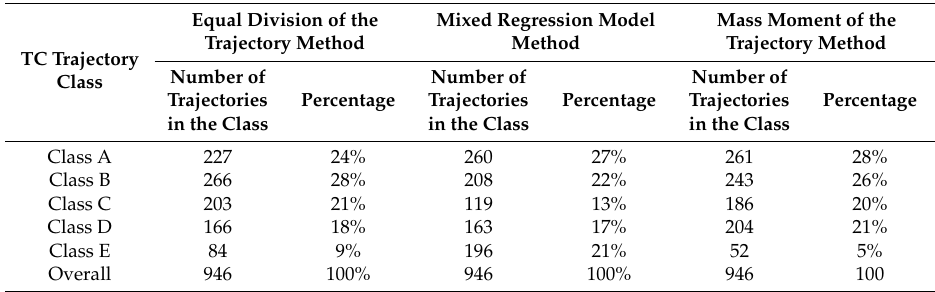
Table 2. Number of TC trajectories in the different classes and the proportion relative to the total TC number.